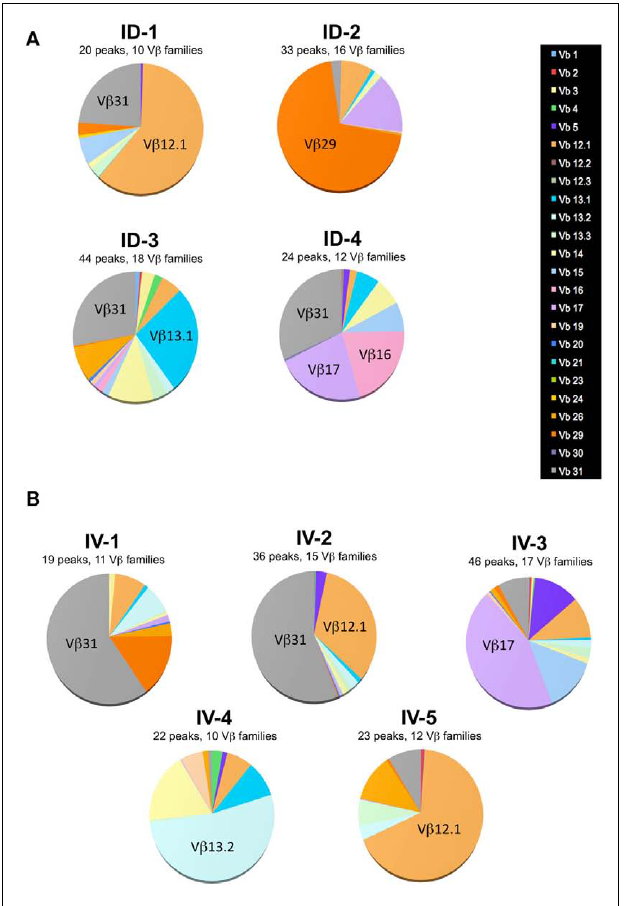
FIGUREA2 | Single mouse analysis confirms that route of immunization does not influenceT cell diversity. Mice were immunized i.d. (A) or i.v. (B) with 5 × 10 5 K bm1 mOva splenocytes. On day 9, 15 macroscopic lymph nodes and the spleen were harvested and a K b –SIINFEKL tetramer-based enrichment was performed for each mouse. CD8 K b –SIINFEKL tetramer-positive cells were sorted. Immunoscope was performed on cells sorted from individual mice (3,000–5,000 cells sorted per mouse) to define the length of the CDR3 loop in the 24V β families (IMGT nomenclature). Each color represents a distinctV β family.